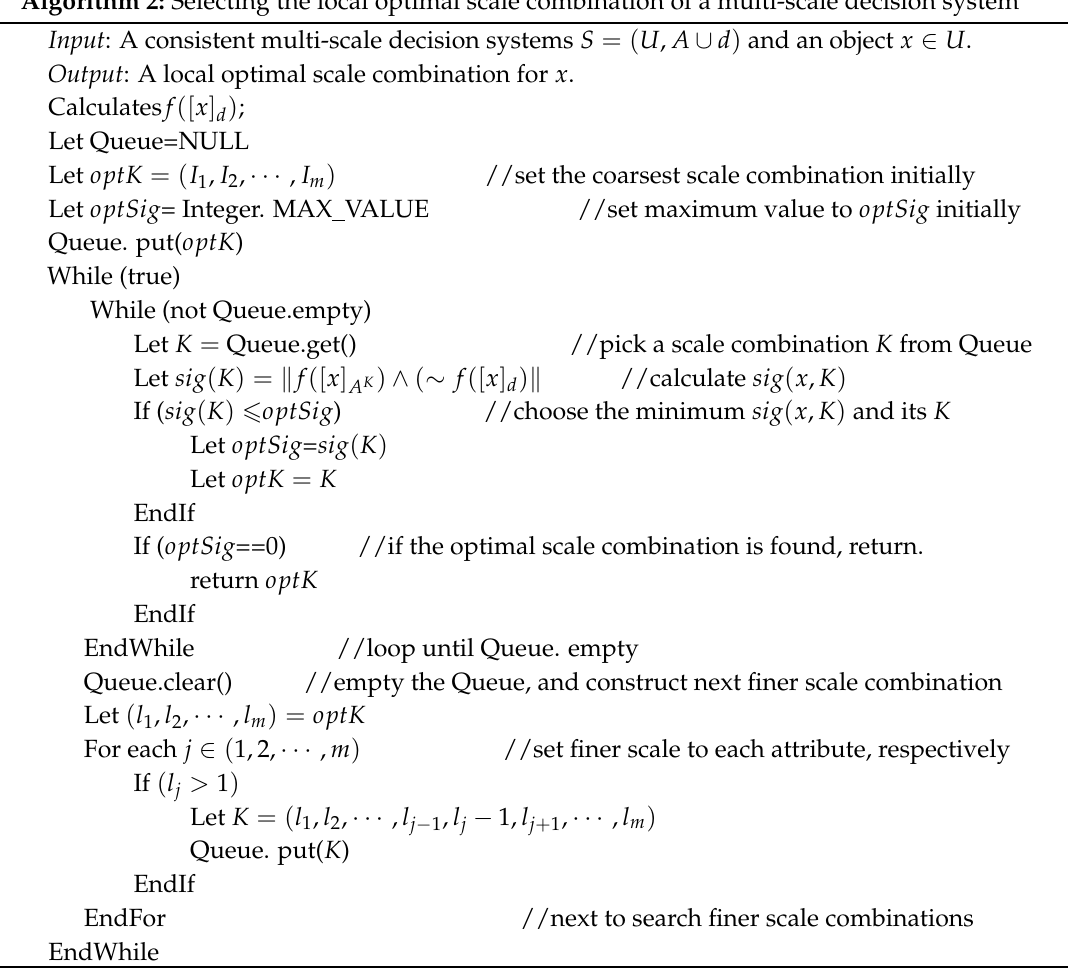
Algorithm 2: Selecting the local optimal scale combination of a multi-scale decision